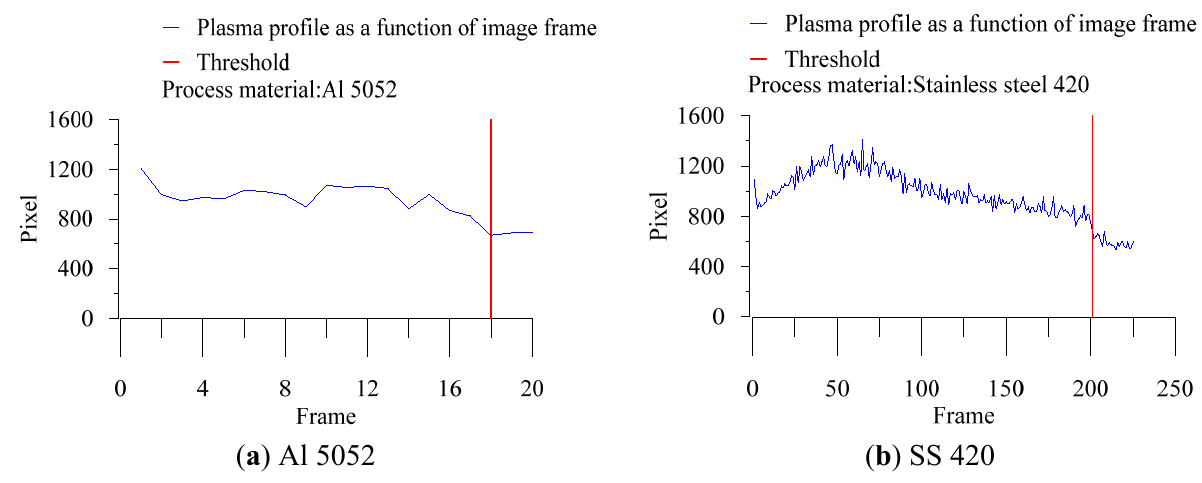
Figure 4. Breakthrough result based on abrupt decline in pixels of plasma